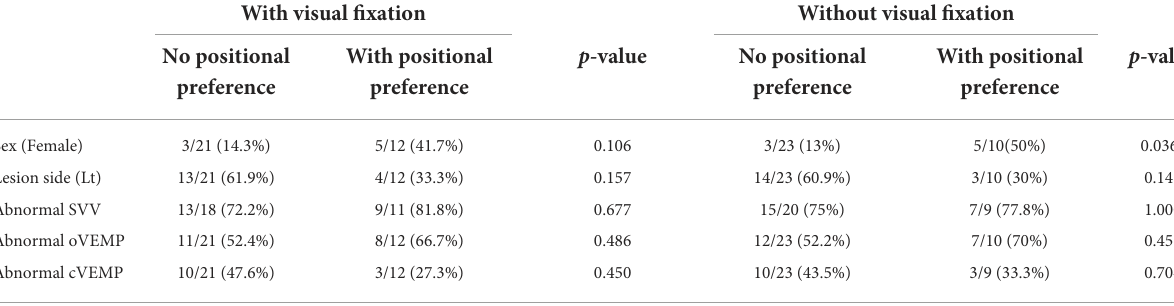
TABLE 2 Sex, lesion side, otolithic function test results between patients with and without positional